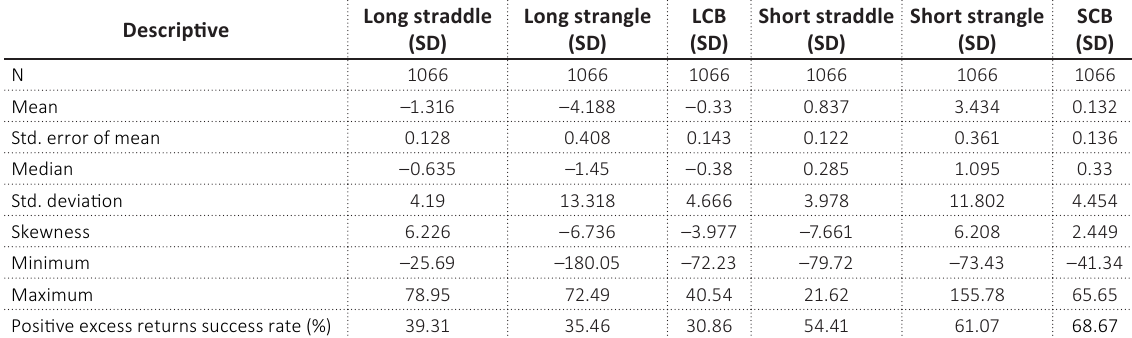
Table 7. Excess returns to standard deviation in volatile market condition